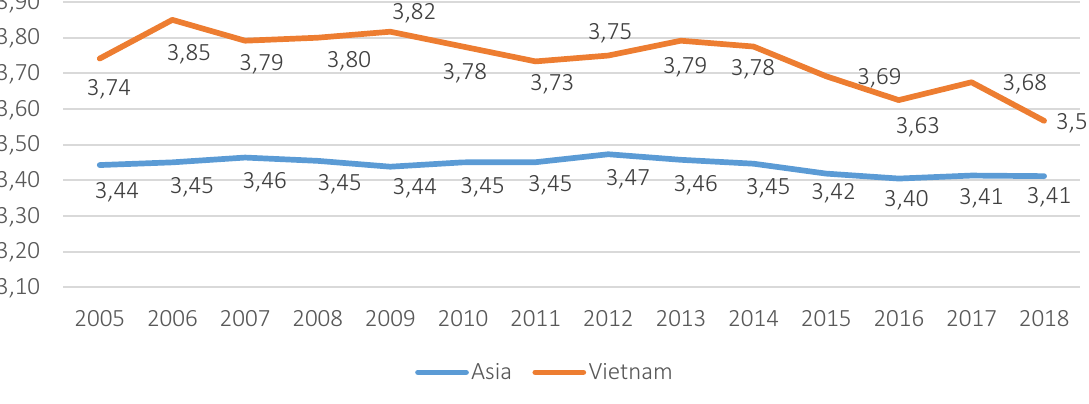
Figure 2. Institutional quality of Vietnam compared to the average of Asian countries